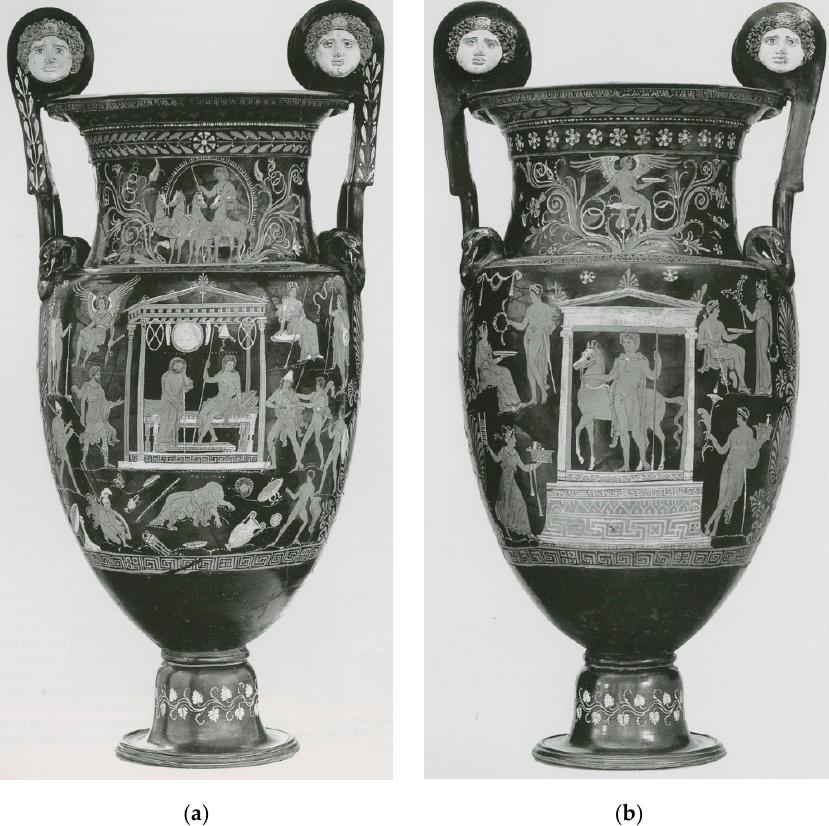
Figure 10. Boston 03.804 Apulian volute-krater, close to the Varrese Painter, ca. 340 B.C. ( a ) Helios in floral surround (neck) and death of Thersites (body). ( b ) Eros seated on flower in floral setting (neck) and youth with horse in naiskos surrounded by three women and three youths with offerings (body). Photographs © Museum of Fine Arts, Boston.